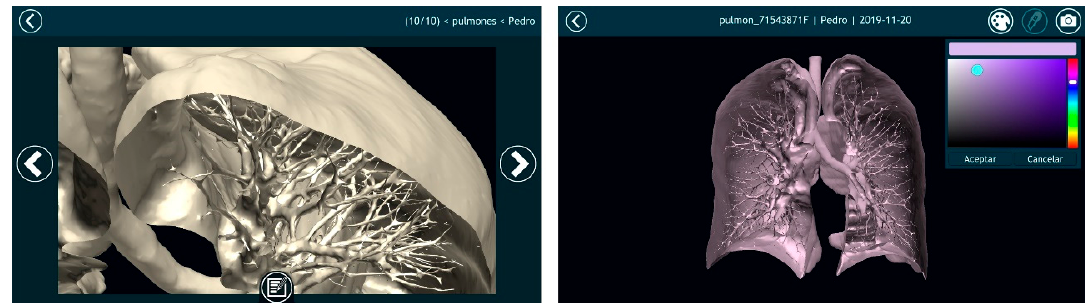
transversal cut. transversal cut. Sensors 2020 , 20 , x FOR PEER REVIEW